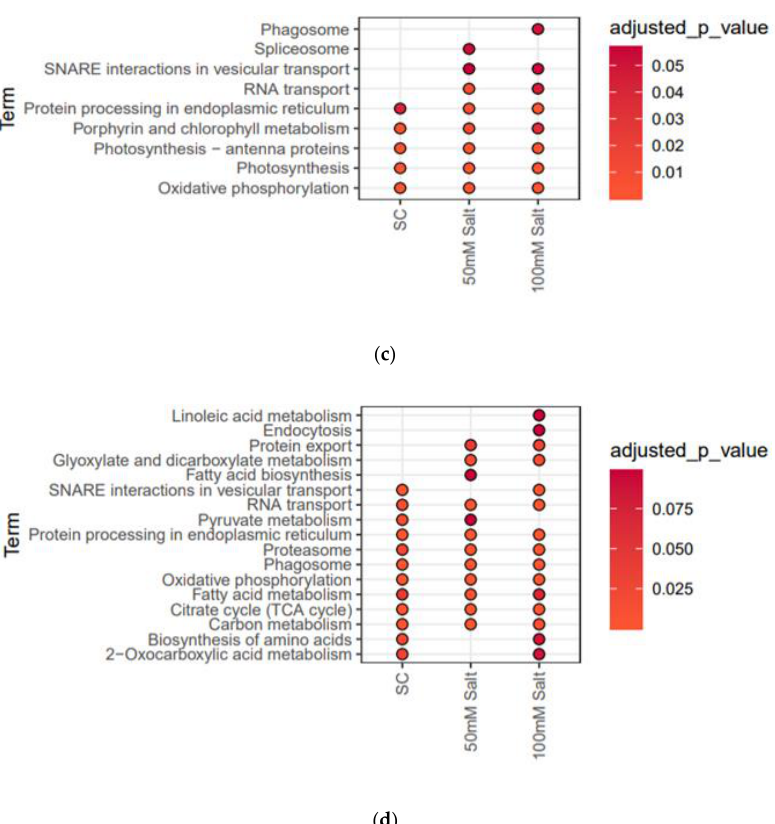
Figure 3. Gene ontology (GO) analyses and Kyoto Encyclopedia of Genes and Genomes (KEGG) pathway analyses of whole-proteome data of leaf and root tissues under control (SC) and 50 mM and 100 mM NaCl treatments. ( a ) Molecular-function GO enrichment of identified proteins in leaves under control and salt treatments. ( b ) Molecular-function GO enrichment of identified proteins in roots under control and salt treatments. ( c ) KEGG pathway enrichments of control and salt-treated leaf samples. ( d ) KEGG pathway enrichments of control and salt-treated root samples. In the identified proteomes, about 50% of the proteins in both leaf and root tissues were categorized as membrane proteins under cellular component in the UniProt Knowledgebase [19]. All the identified membrane proteins had transmembrane domains (Supplementary Tables S1 – S4). In total, we identified 972 membrane proteins from the leaf and root tissues combined, in which 421 proteins were commonly shared by both tissues, 320 membrane proteins were root-specific, and 233 were leaf-specific (Figure 4a). The 972 membrane proteins were further categorized on the basis of their subcellular lo- cations, enzyme activities and the domains they contain (Supplementary Tables S1 – S4).